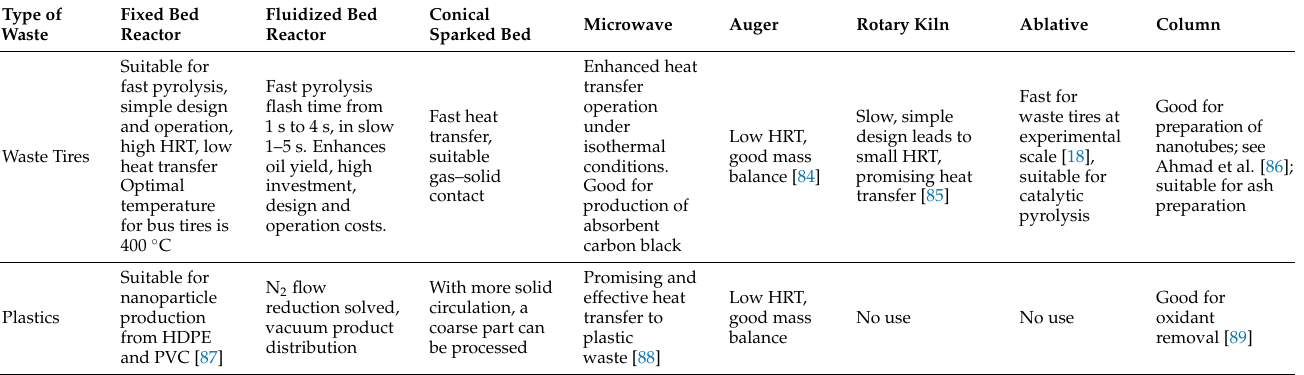
Table 4. Comparison of reactors for pyrolysis of waste tires and plastic.